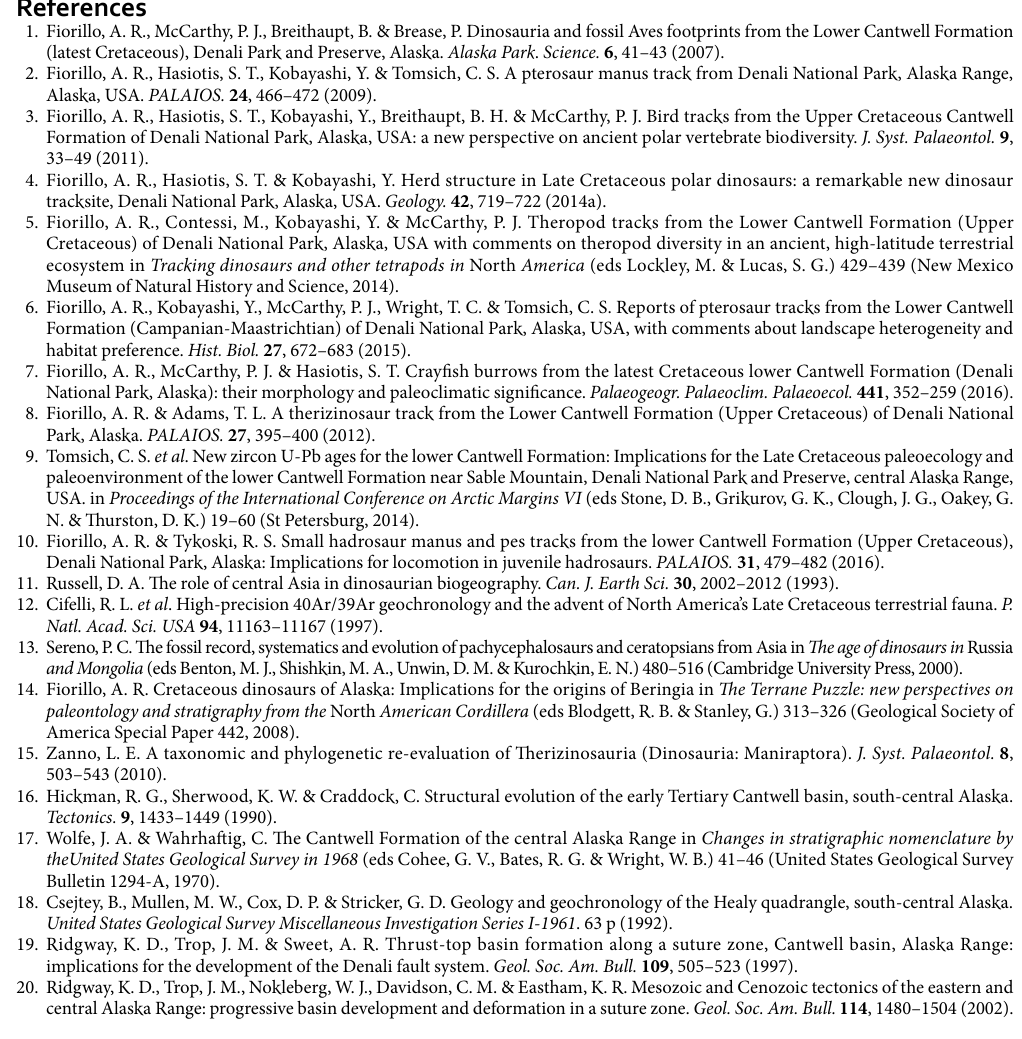
exported as a binary STL file. Individual model data are available in Table S2. Original model files are provided in Supporting Information. The Z-axis of two models (DMNH 2013-08-06 and DMNH 2014-11-05) was inverted using Autodesk Meshmixer (v.3.0) in order to recreate the positive relief of the original tracks. Each mesh was aligned to a plane and colorized by Z-axis height in CloudCompare (v.2.7) 82,83 .